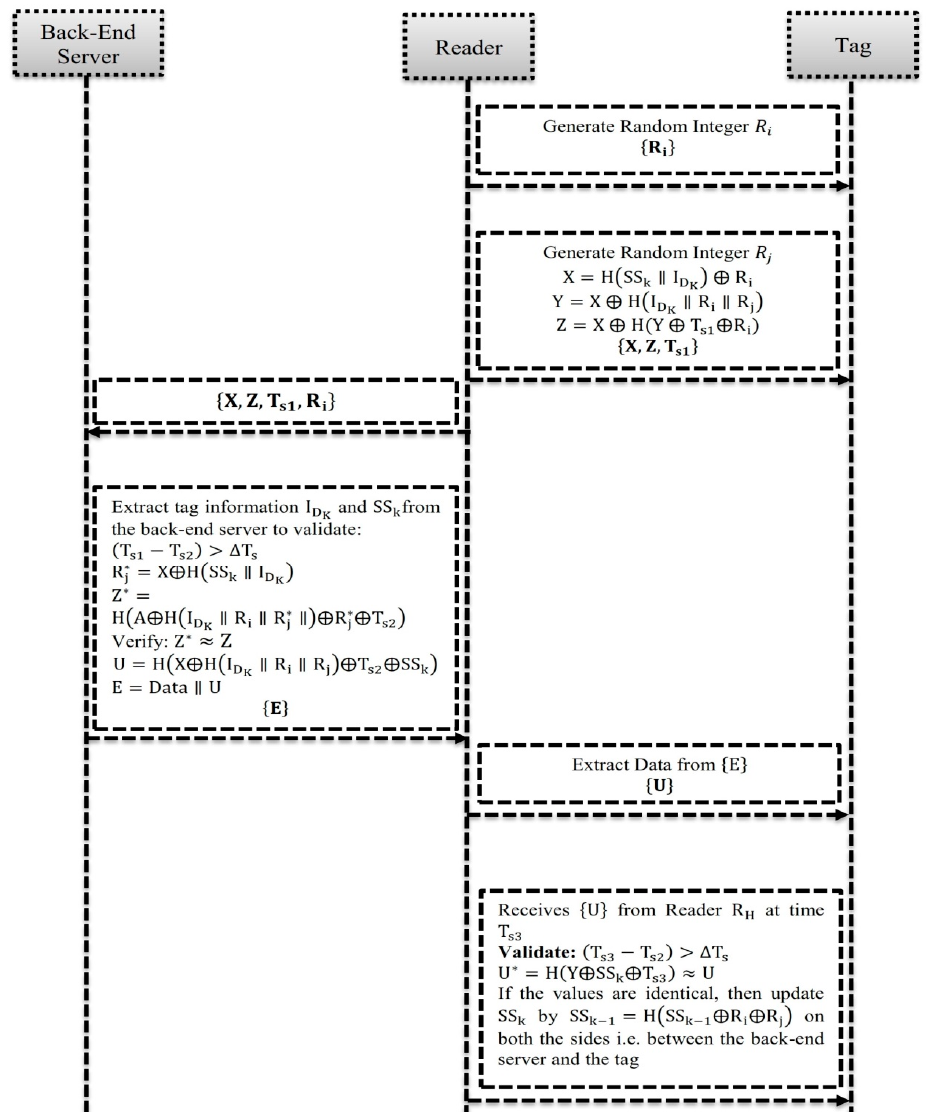
Figure 3. Proposed workflow of the novel hash-based RFID mechanism.